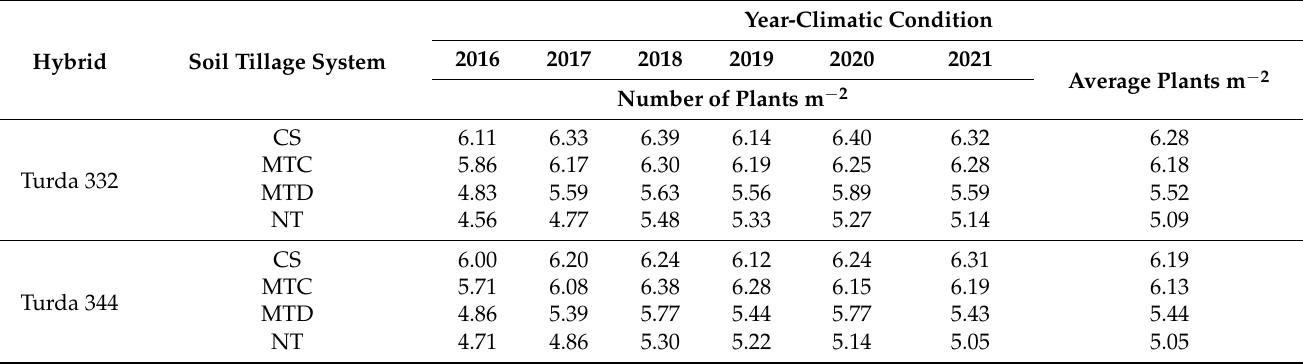
Table 4. Influence of experimental factors on the number of harvestable plants m − 2 ,